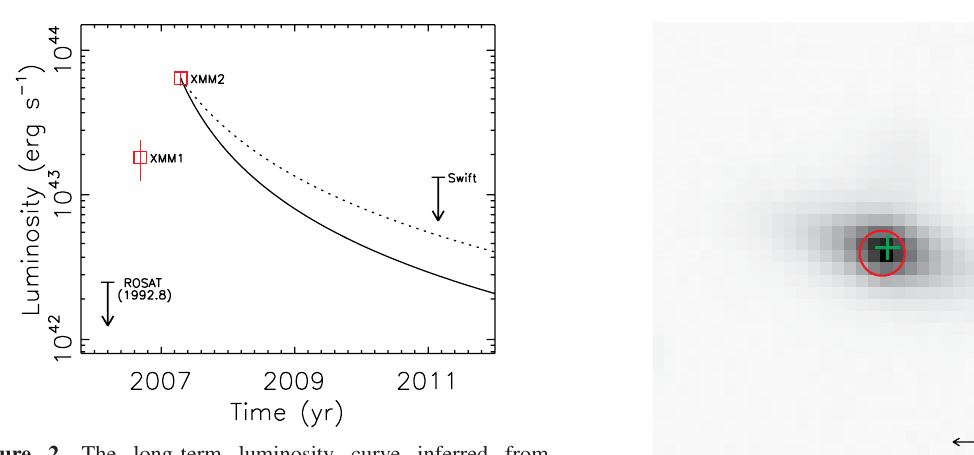
Figure 2. The long-term luminosity curve inferred from X-ray spectral fits [19]. Arrows represent 3- σ upper bounds. Note that the ROSAT observation was made in 1992 October. The solid curve is Luminosity = 3 . 45 × 10 43 [(Time − 2006 . 60yr) / (1yr)] − 5 / 3 erg s − 1 , and the dotted curve is Luminosity = 7 . 57 × 10 43 [(Time − 2006 . 18yr) / (1yr)] − 5 / 3 ergs − 1 .